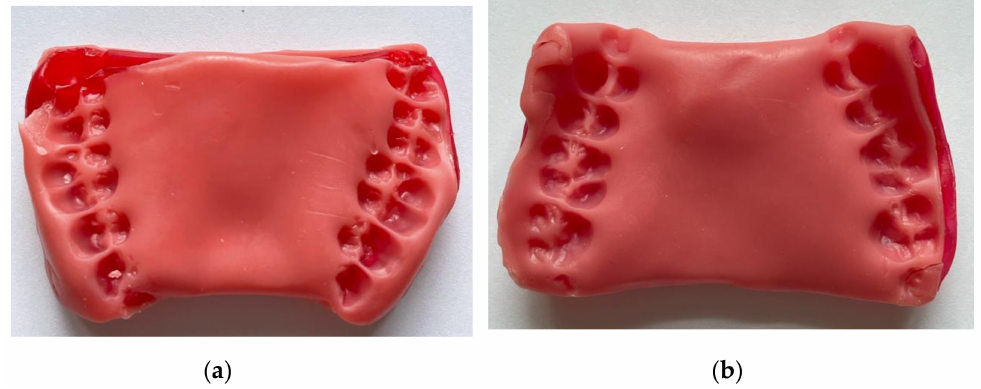
Figure 1. Wax registration for mandibular repositioning. ( a ) Lower side; ( b ) Upper side. Three waxes registrations were performed: (i) the first wax advancing the jaw and aligning maxillary and mandibular labial frenula; (ii) the second one advancing the jaw without aligning labial frenula (this wax was registered only if a labial frenula discrepancy was present); (iii) the last one in a minimal vertical occlusal dimension increase. In the first two waxes, the jaw was advanced until it reached an ideal vertical and sagittal inter-incisal relation according to Björk [22] with 2 mm of overjet and overbite. In the third wax, vertical occlusal dimension was increased until the first dental contact was